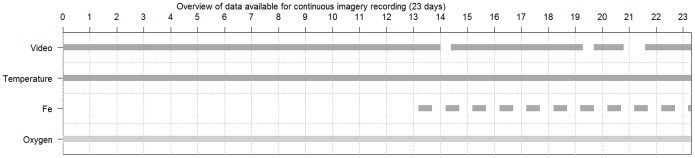
Data overview for continuous imagery duration.Data overview for continuous imagery duration, i.e. 559∼23 days, during which video recording was programmed to be continuous. The gaps in the recordings were unusable video sequences (empty, black or unfocused). Temperature was recorded continuously (1 measurement every 30 seconds). For this period, Fe was measured once a day from October 20, 2011 onward. Oxygen was recorded continuously for the period, although it showed a steep decrease and other inexplicable patterns until day 83, rendering the data unusable (light-grey).